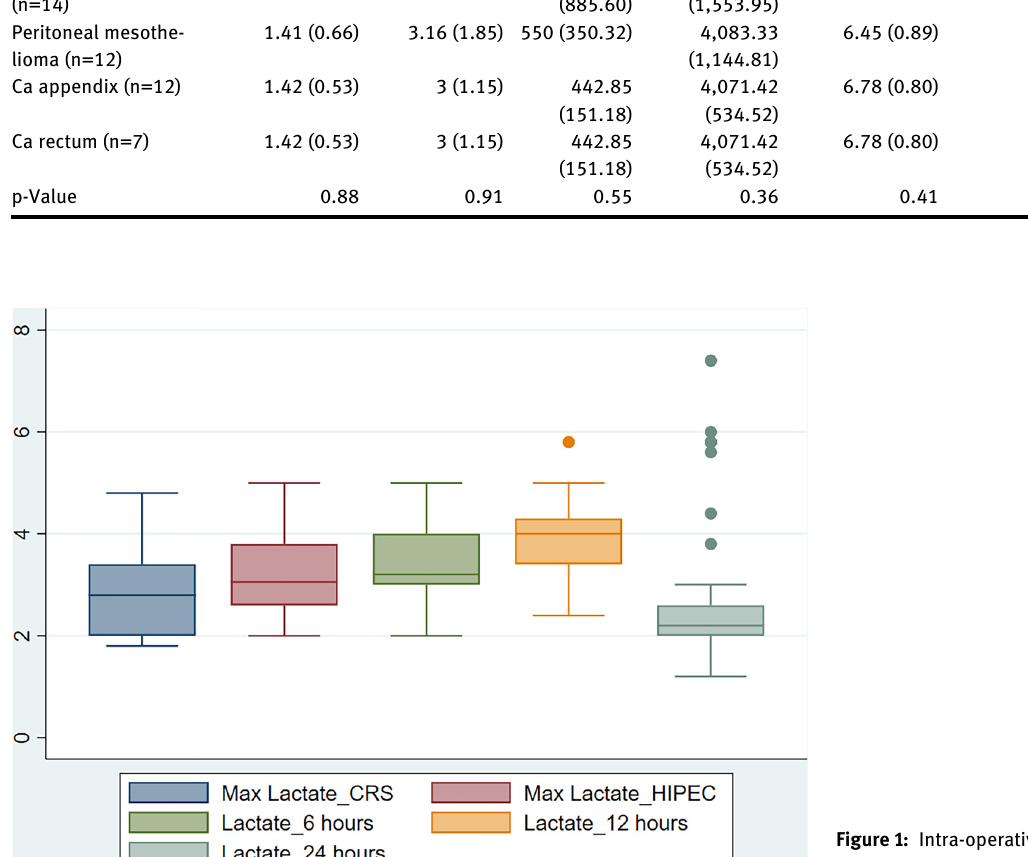
Figure 1: Intra-operative and post-operative course of lactate (Box Plot).